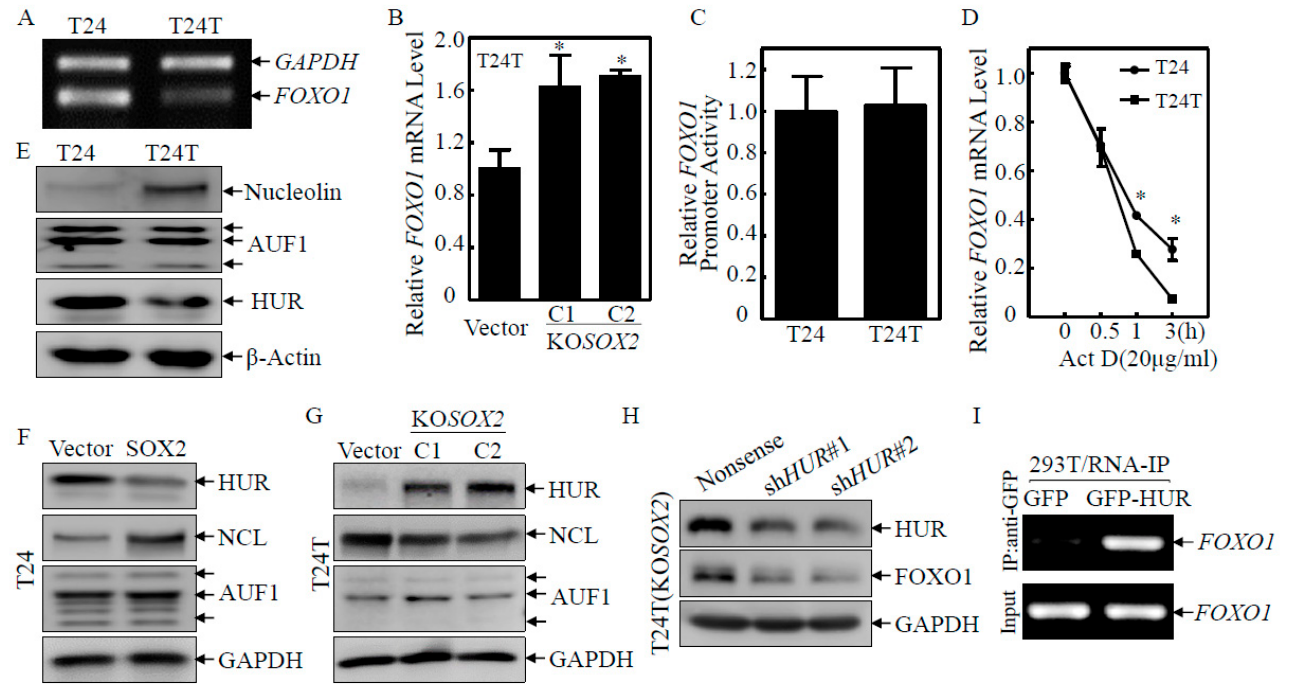
Figure 3. HUR downregulation was responsible for SOX2-mediated FOXO1 mRNA destabilization. ( A , B ) The indicated cells were extracted with TRIzol reagent to isolate total RNA upon the density reaching 80–90%. The FOXO1 mRNA levels were determined with RT-PCR ( A ) or Real-time PCR ( B ) by using the specific primers. GAPDH was used as an internal control. The asterisk (*) indicates a significant difference in FOXO1 mRNA level in comparison to their corresponding vector control transfectants ( p < 0.05). ( C ) The indicated cells were transfected with a FOXO1 promoter-driven luciferase reporter together with pRL-TK. The transfectants were seeded into 96-well plates and then subjected to determine the FOXO1 promoter activity by measuring the luciferase activity. pRL-TK was used as an internal control to normalize the transfection efficiency. Each bar indicates the mean ± SD from three replicate assays. ( D ) T24 and T24T cells were seeded into six-well plates. After synchronization, the T24 and T24T cells were treated with actinomycin D (Act D) for the indicated time points, and then the total RNA was isolated and subjected to Real-time PCR analysis to evaluate the mRNA levels of FOXO1 normalized to internal control GAPDH . The asterisk (*) indicates a significant difference in FOXO1 mRNA level in comparison to T24T cell line ( p < 0.05). ( E – H ) T24 and T24T stable transfectants as indicated were extracted, and the cell extracts were subjected to Western blot to determine the expression of the indicated proteins. GAPDH was used as a protein loading control. ( I ) 293T cells transfected with GFP-tagged HUR were used to perform